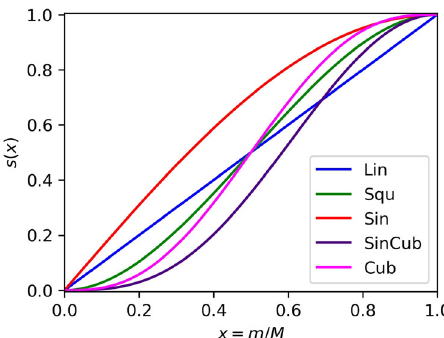
Fig. 1 Plots of the scheduling functions tested in Eq. 1.